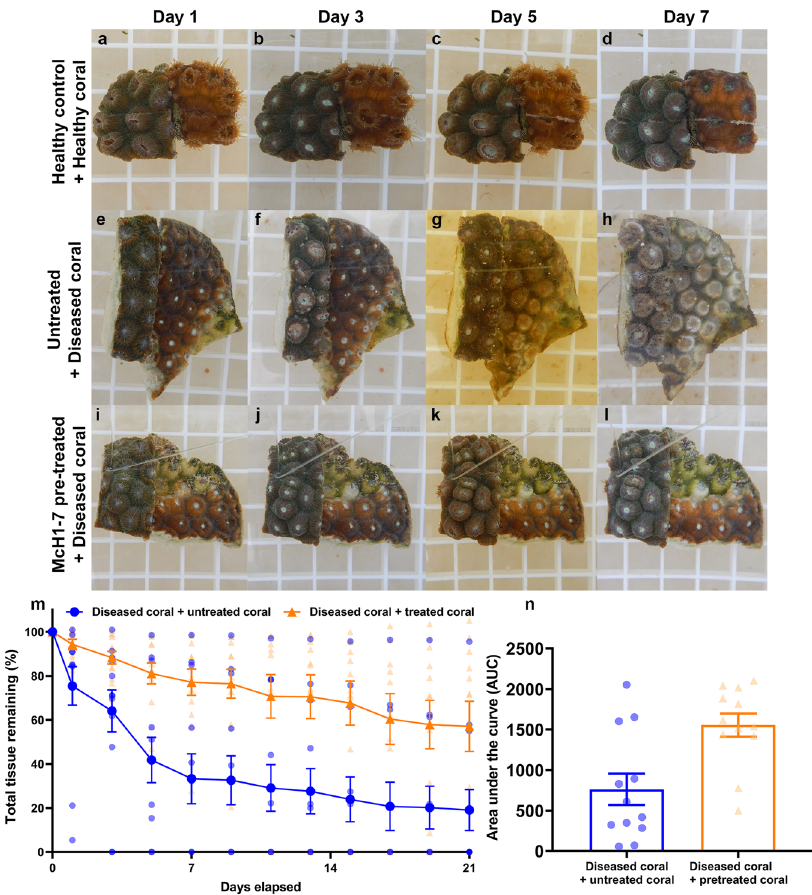
Fig. 5 Protection from disease transmission with McH1-7. a – d Photos of control M. cavernosa consisting of a healthy fragment pre-treated with McH1-7 (left) in contact with an untreated healthy fragment (right), e – h untreated healthy fragment (left) in contact with a diseased fragment (right), and i – l ) a healthy fragment pre-treated with McH1-7 (left) in contact with a diseased fragment (right). Photos represent days 1, 3, 5, and 7 of the experiment. m Average percentage of total tissue remaining on diseased M. cavernosa colonies in contact with untreated healthy fragments (blue circles) or McH1-7 treated healthy fragments (orange triangles) over time (mixed-effects model ANOVA; treatment P = 0.004, time P < 0.001, interaction P < 0.0001; n = 12). n Area under the curve (AUC) calculations for the diseased M. cavernosa in contact with untreated fragments (blue bar) or fragments pre-treated with McH1-7 (orange bar) (paired t test, P = 0.0001, n = 12). The error bars represent the standard error of the